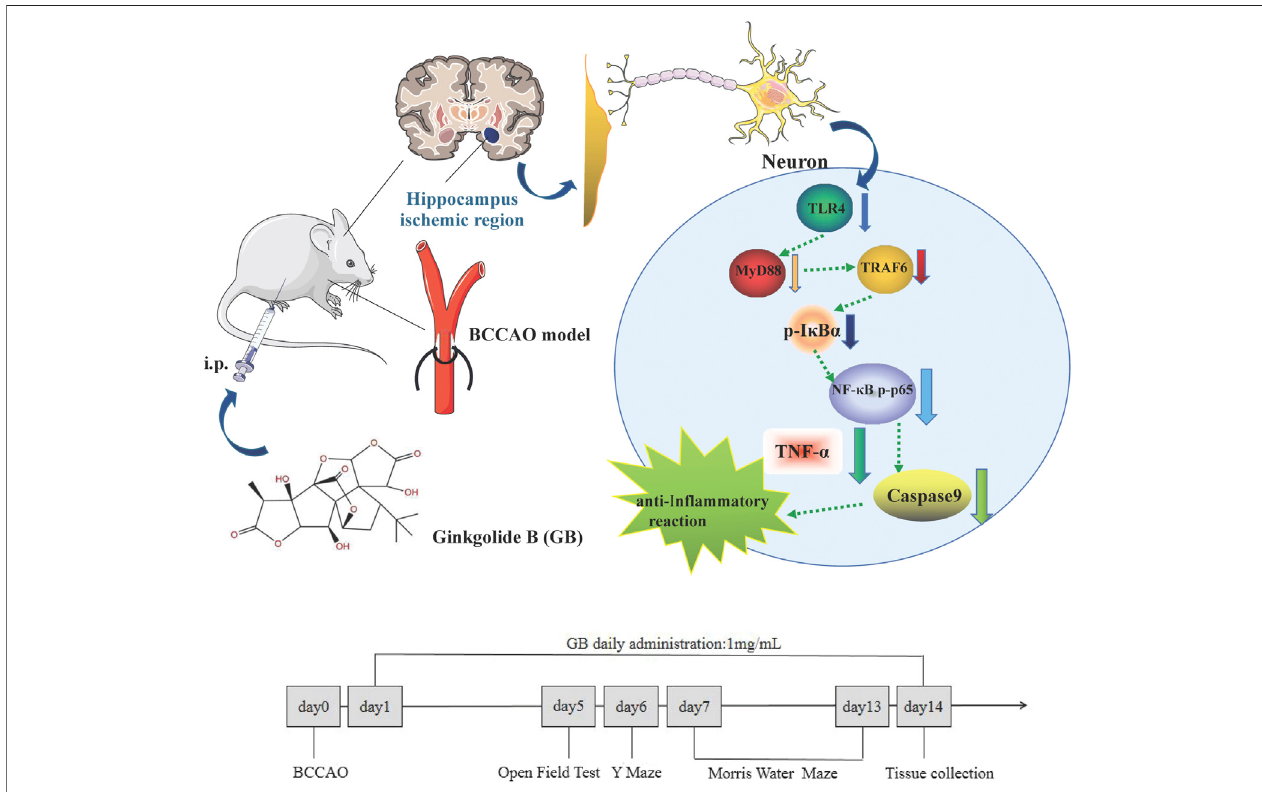
FIGURE 1 | Graphical Abstract: Ginkgolide B alleviates learning and memory impairment in rats with vascular dementia by reducing TLR4/NF- κ B mediated neuroin fl ammation.